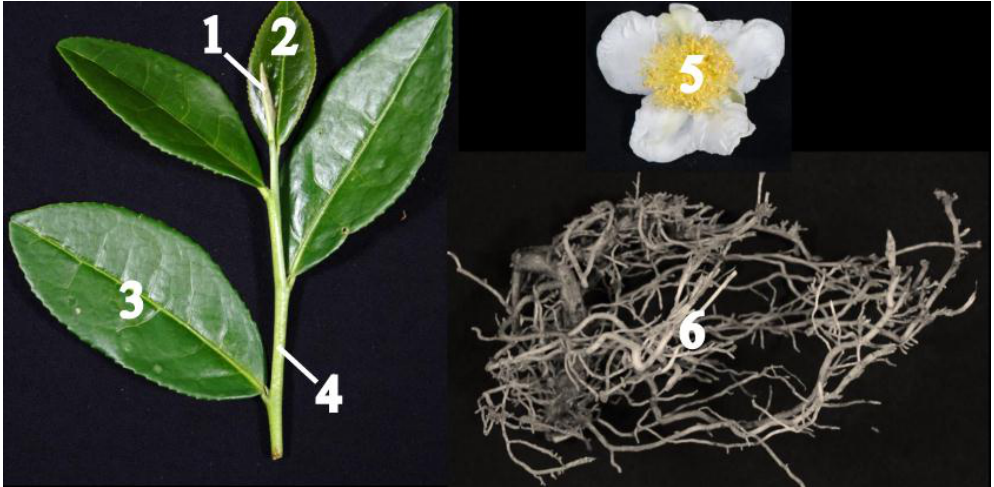
Figure 1. Phenotypic characterization of six tissues of Tieguanyin tea plants used in the current study. (1) bud, (2) young leaf, (3) mature leaf, (4) new stem, (5) flower, and (6) lateral root.